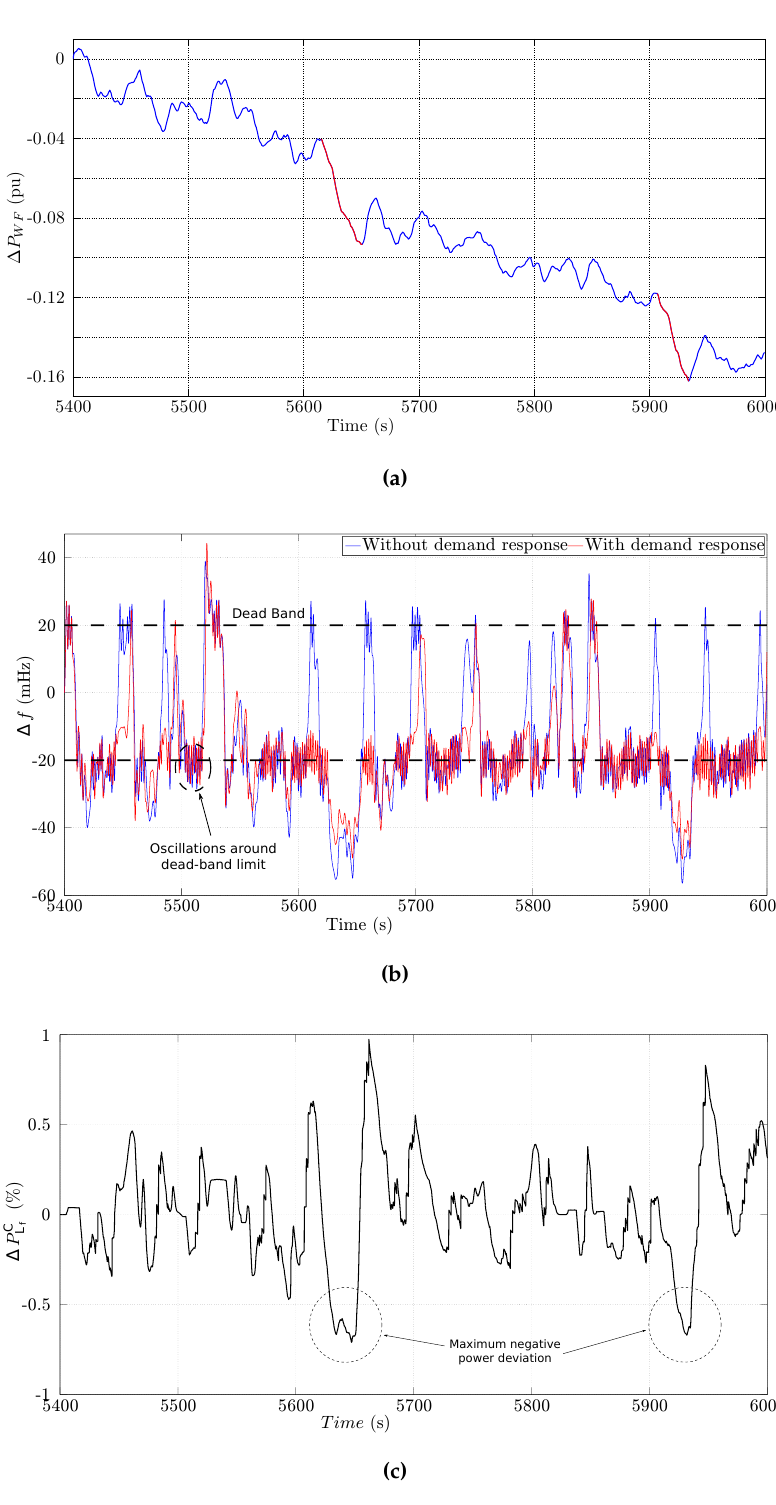
Figure 10. Results for a specific case study. ( a ) ∆ P WF for the most critical interval considered in the simulations; ( b ) example of the temporal evolution of frequency deviations when demand response is or not applied; ( c ) aggregated forced demand